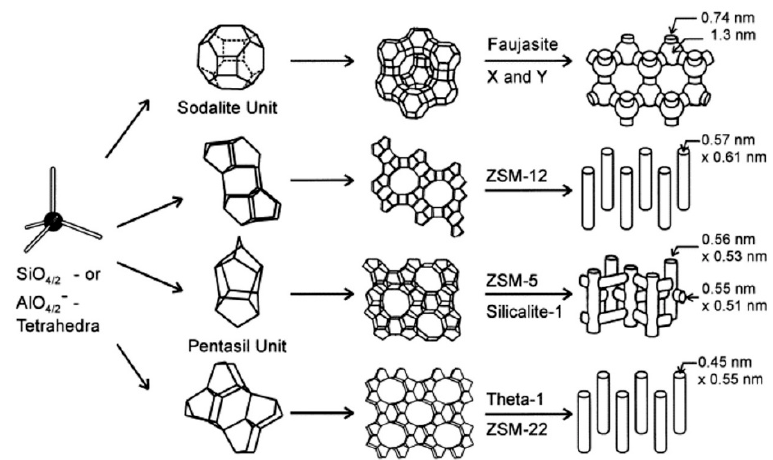
Figure 5. Structures of four commercial zeolites (from top to bottom: Faujasite or zeolites X, Y; zeolite ZSM-12; zeolite ZSM-5 or silicalite-1; zeolite Theta-1 or ZSM-22) and their micropore systems and dimensions. Reprinted from Reference [62], with permission from Elsevier.